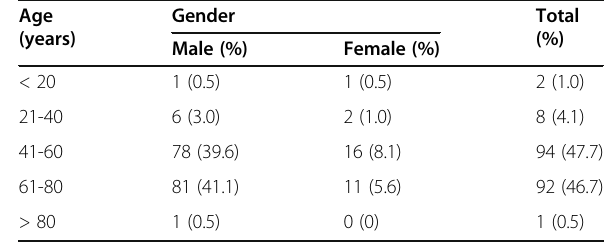
Table 3 Distribution of number of exacerbations